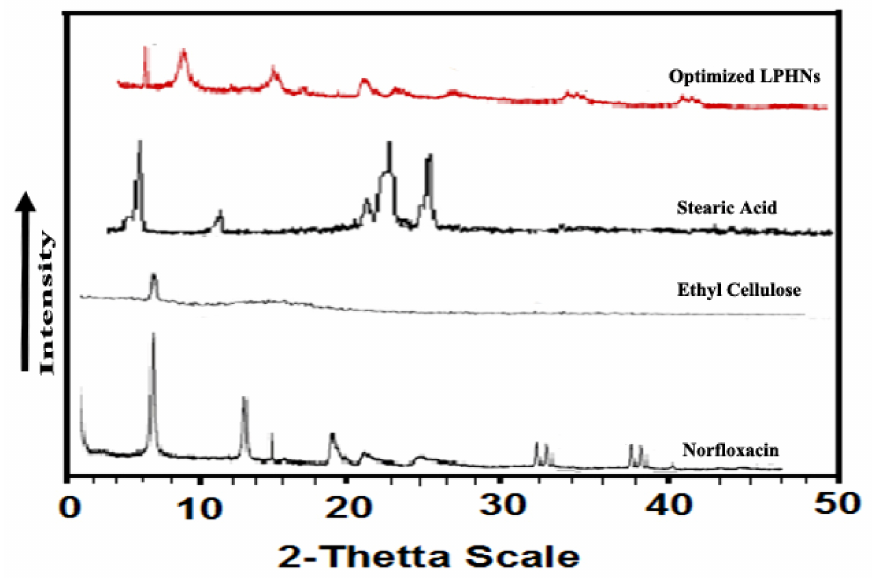
Figure 5. P-XRD of stearic acid, ethyl cellulose as well as processed (NOR-5) and unprocessed